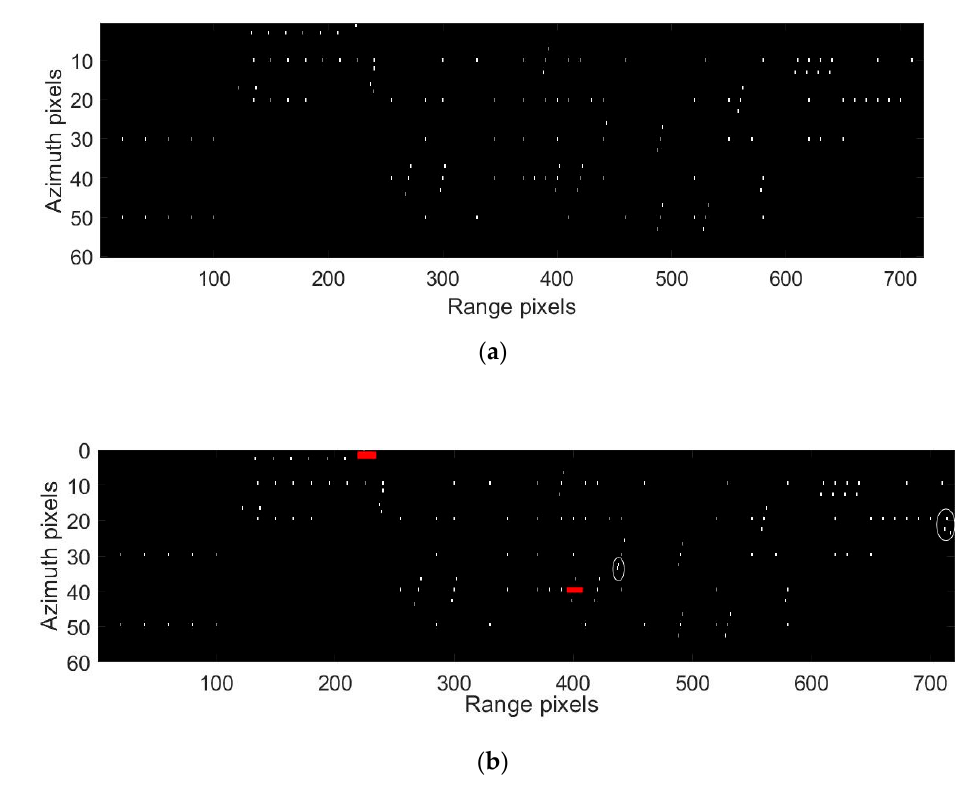
Figure 10. MTs and detection results after joint sparse-based refocusing: ( a ) simulated MTs, and ( b ) detection results. Table 4. Detection results on the reconstructed MT imagery.